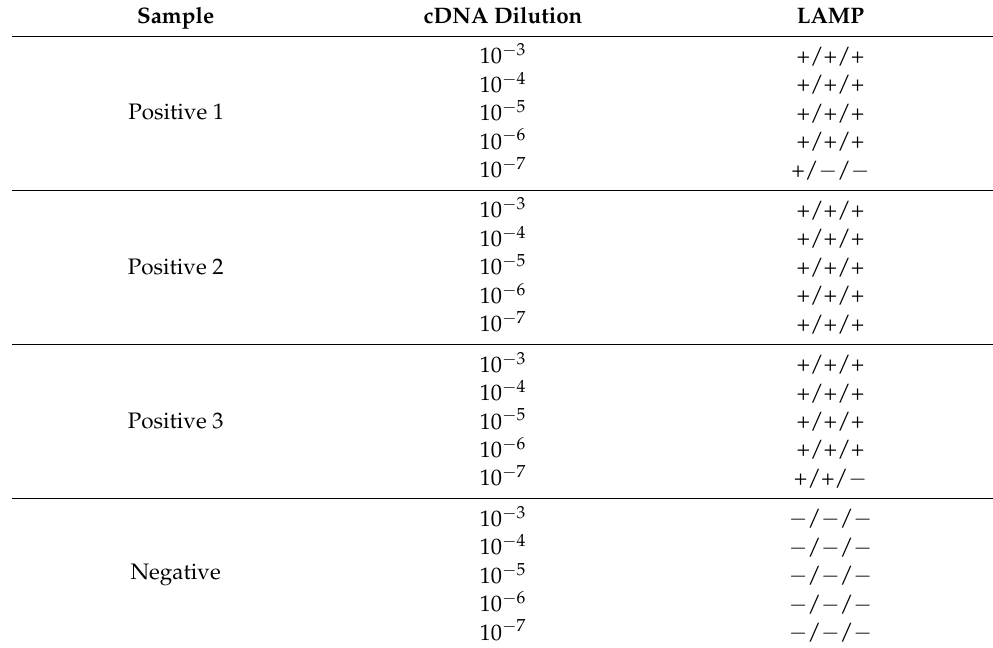
Table 3. LAMP assay on serial dilutions of cDNA from three SBCMV-infected wheat plants mechani- cally inoculated. Experiment performed in the CFX